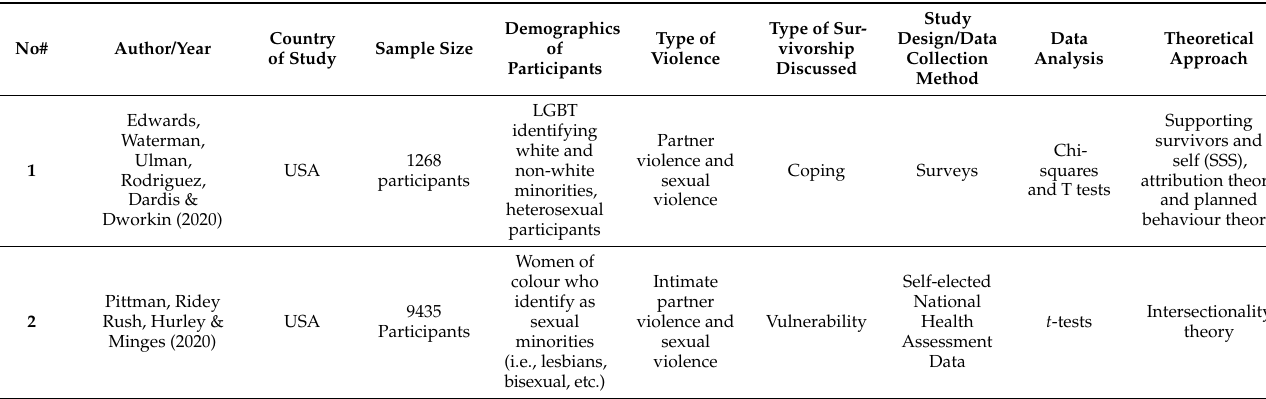
Table 2. Characteristics of included